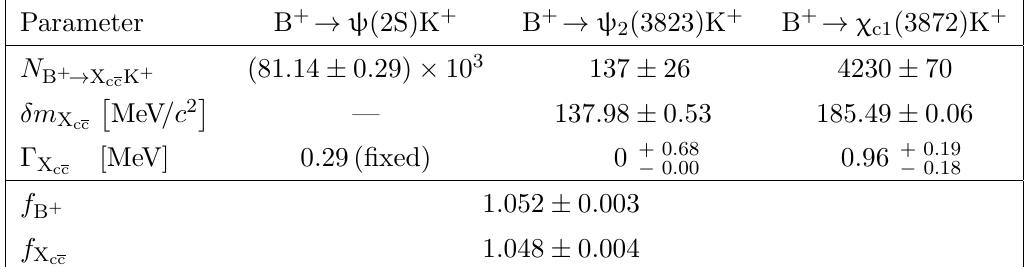
Table 1 . Parameters of interest and derived quantities from the simultaneous unbinned extended maximum-likelihood two-dimensional (cid:12)t. Results and statistical uncertainties are shown for the three (cid:12)t